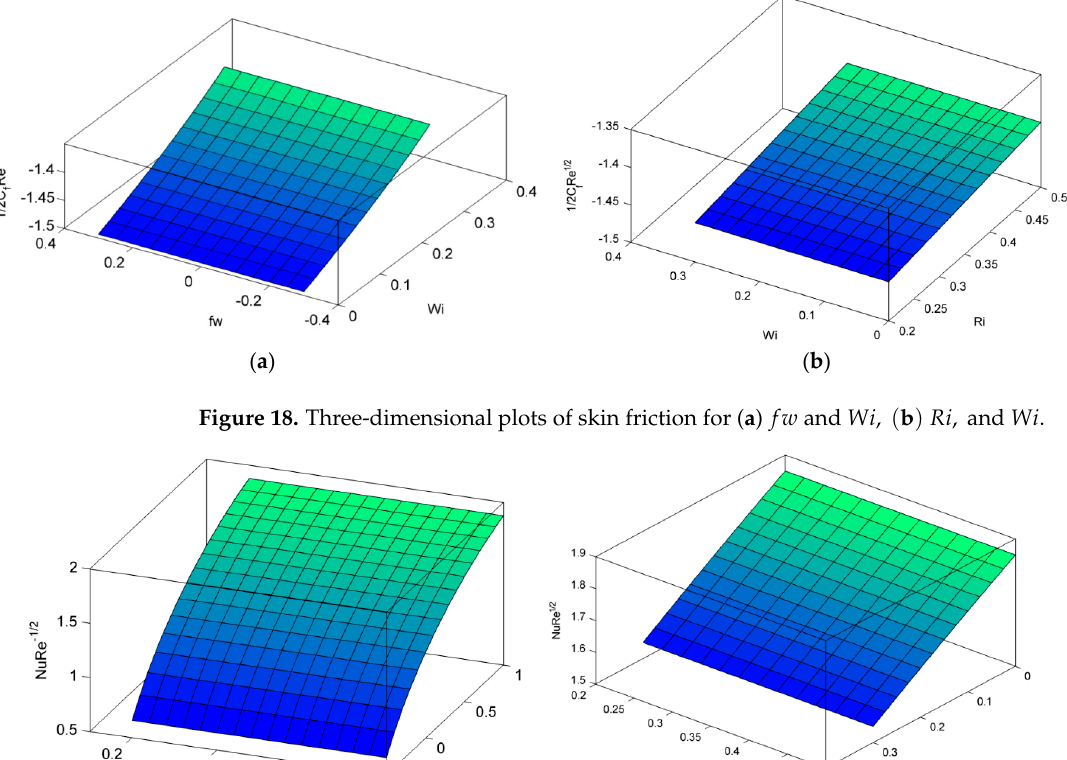
increased in this case as the values of fw and S φ increased, and Sc and ω φ also increased.